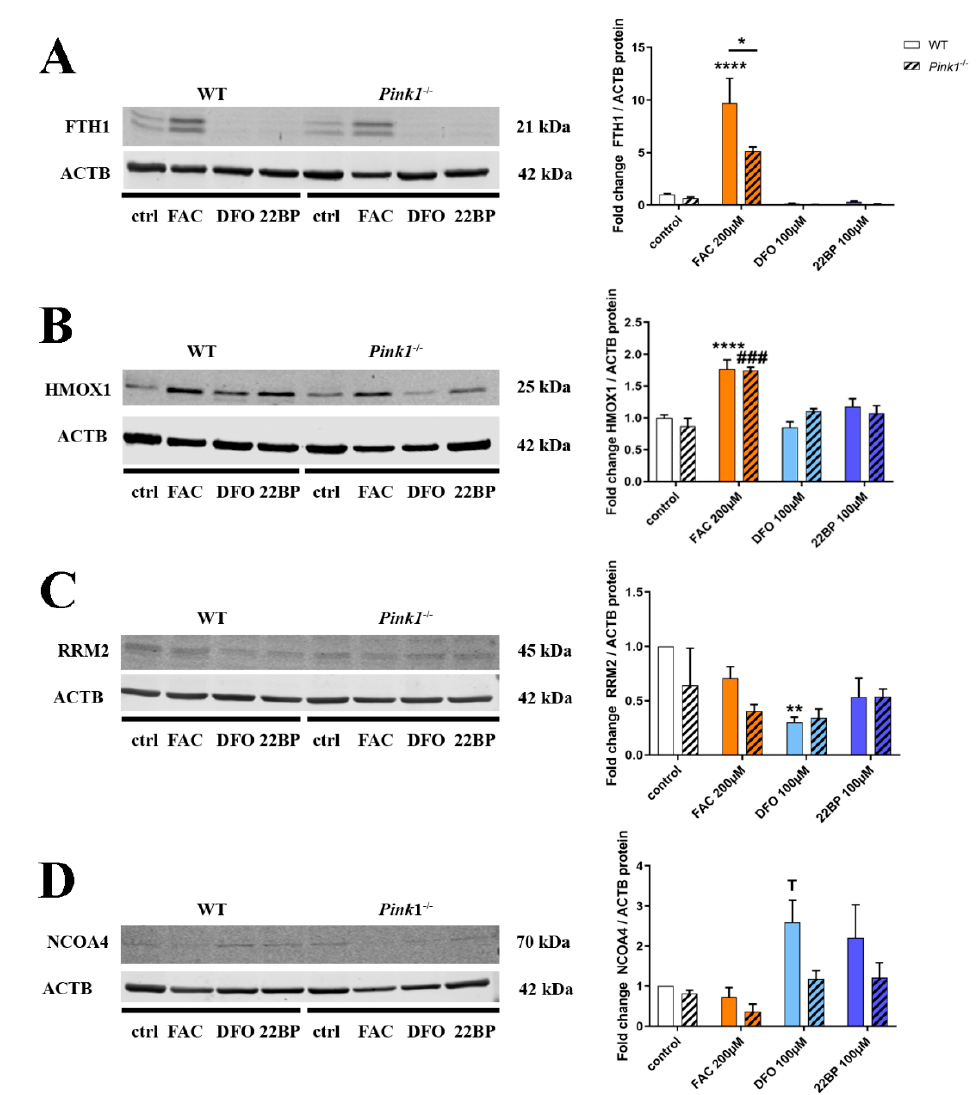
Figure 5. Quantitative immunoblots for (A) FTH1, (B) HMOX1 , (C) Ribonucleotide reductase regulatory subunit M2 (RRM2), and (D) nuclear receptor coactivator 4 (NCOA4) in WT and Pink1 − / − MEF, under untreated control conditions (Ctrl), after iron overload (FAC) and after two different iron depletion drugs (DFO, 22BP), administered over 48 h. Protein abundance signals were normalized to beta-Actin levels (Actin beta (ACTB)) as a loading control. The panels on the right show their densitometric quantifications, normalized to WT untreated conditions. WT n = 4–6, Pink1 − / − n = 3, one exemplary set is shown. The statistical trends or levels of significance are illustrated by symbols, namely T: 0.1 > p >0.05, * or #: p < 0.05, ** or ##: p < 0.01, ###: p < 0.001, ****: p < 0.0001. Mutant cells are represented by dashed bars, WT cells by plain colors. Asterisks represent significance in WT MEF, treated versus untreated control, while hashtags refer to Pink1 − / − MEF, treated versus untreated control. Genotype-dependent significant differences of Pink1 − / − versus WT MEF are illustrated by horizontal lines below asterisks.